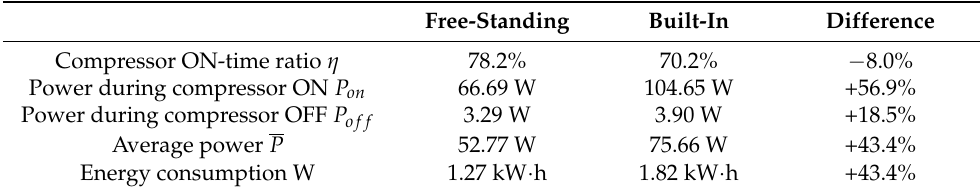
Table 6. Overall refrigerator performance for two configurations. Free-Standing Built-In Difference Compressor ON-time ratio η 78.2% 70.2% − 8.0% Power during compressor ON P on 66.69 W 104.65 W +56.9% Power during compressor OFF P of f 3.29 W 3.90 W +18.5% Average power P 52.77 W 75.66 W +43.4% Energy consumption W 1.27 kW ·